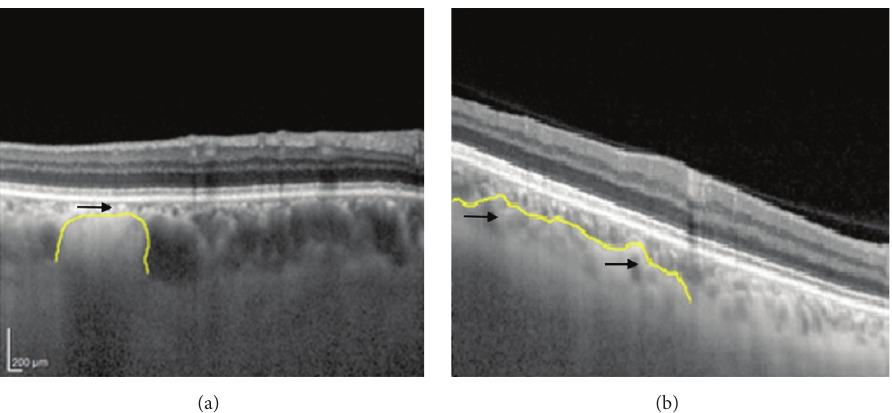
Figure 6: Optical coherence tomography-enhanced depth imaging of choroidal nodules and overlying choroidal vasculature features. (a) Delineated dome-shaped nodule; note the compressed appearance of choroidal vasculature and the absence of large caliber vessels. (b) Delineated placoid nodule; note the random localization of large caliber vessels among the irregular propagations of the placoid nodule (from [26]).